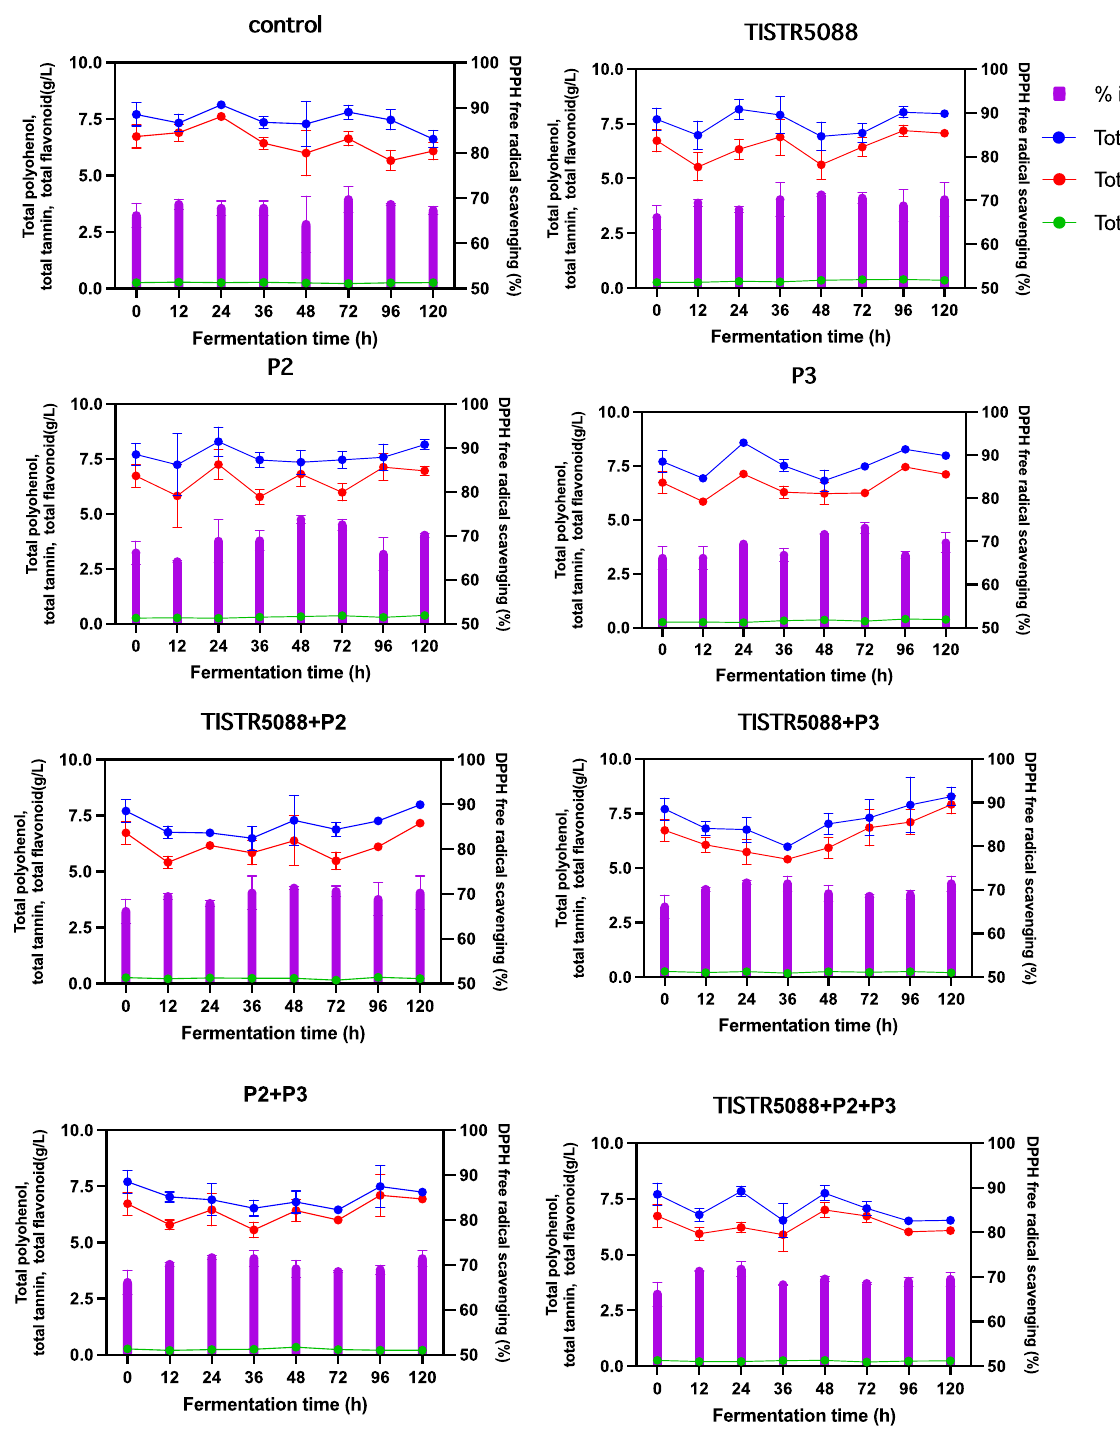
Figure 8. Bioactive compound and antioxidant profiles during the fermentation of MF-broth fermented by S. cerevisiae TISTR 5088, W. anomalus P2 and C. rhodanensis P3, with single and co-fermen- tation.